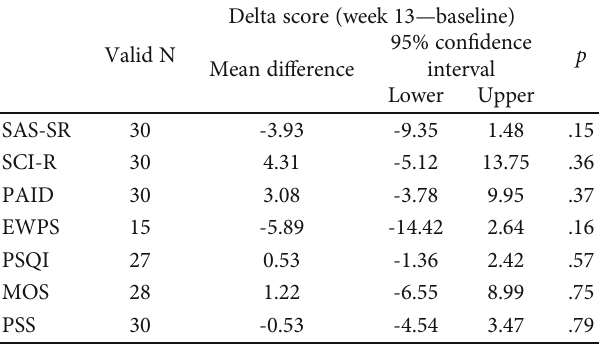
Table 3: Change in quality of life and functioning assessments. Table 4: Adverse events by treatment